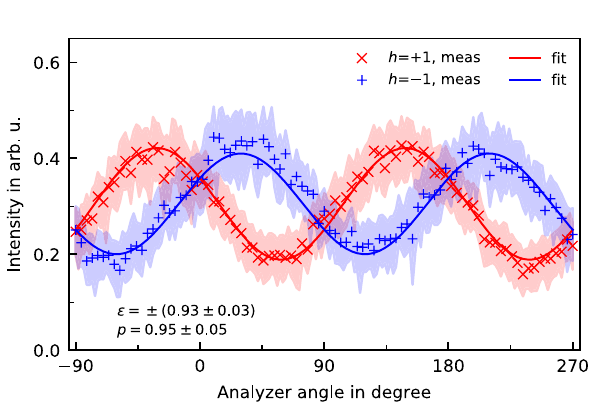
Figure 3. Measured intensities for harmonic order 16 in the cases of positive (blue, ‘+’) and negative helicity (red, ‘x’), with the shaded areas representing the standard